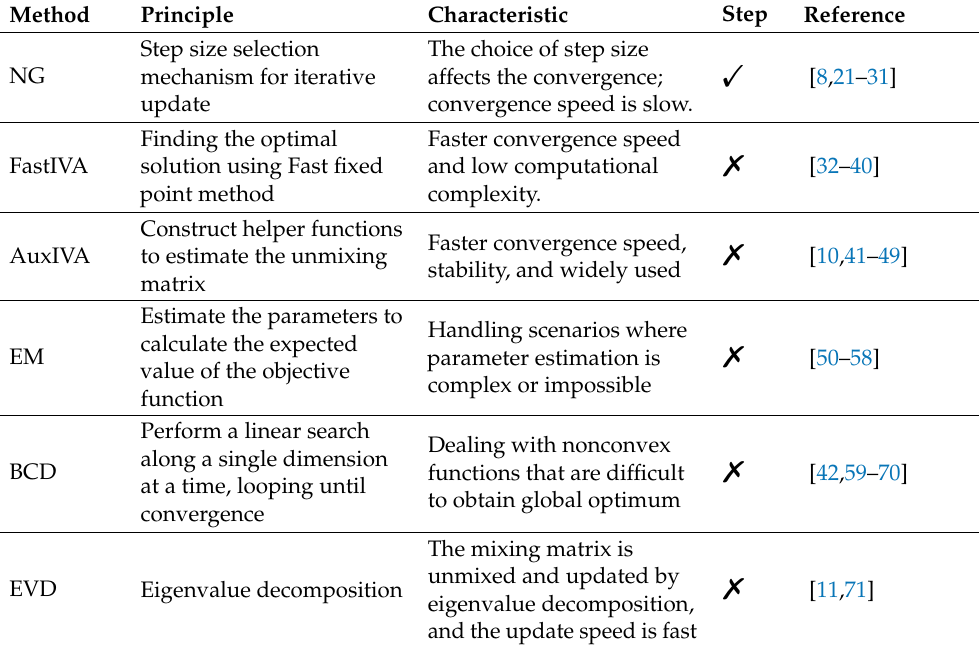
Table 1. Optimize update rule